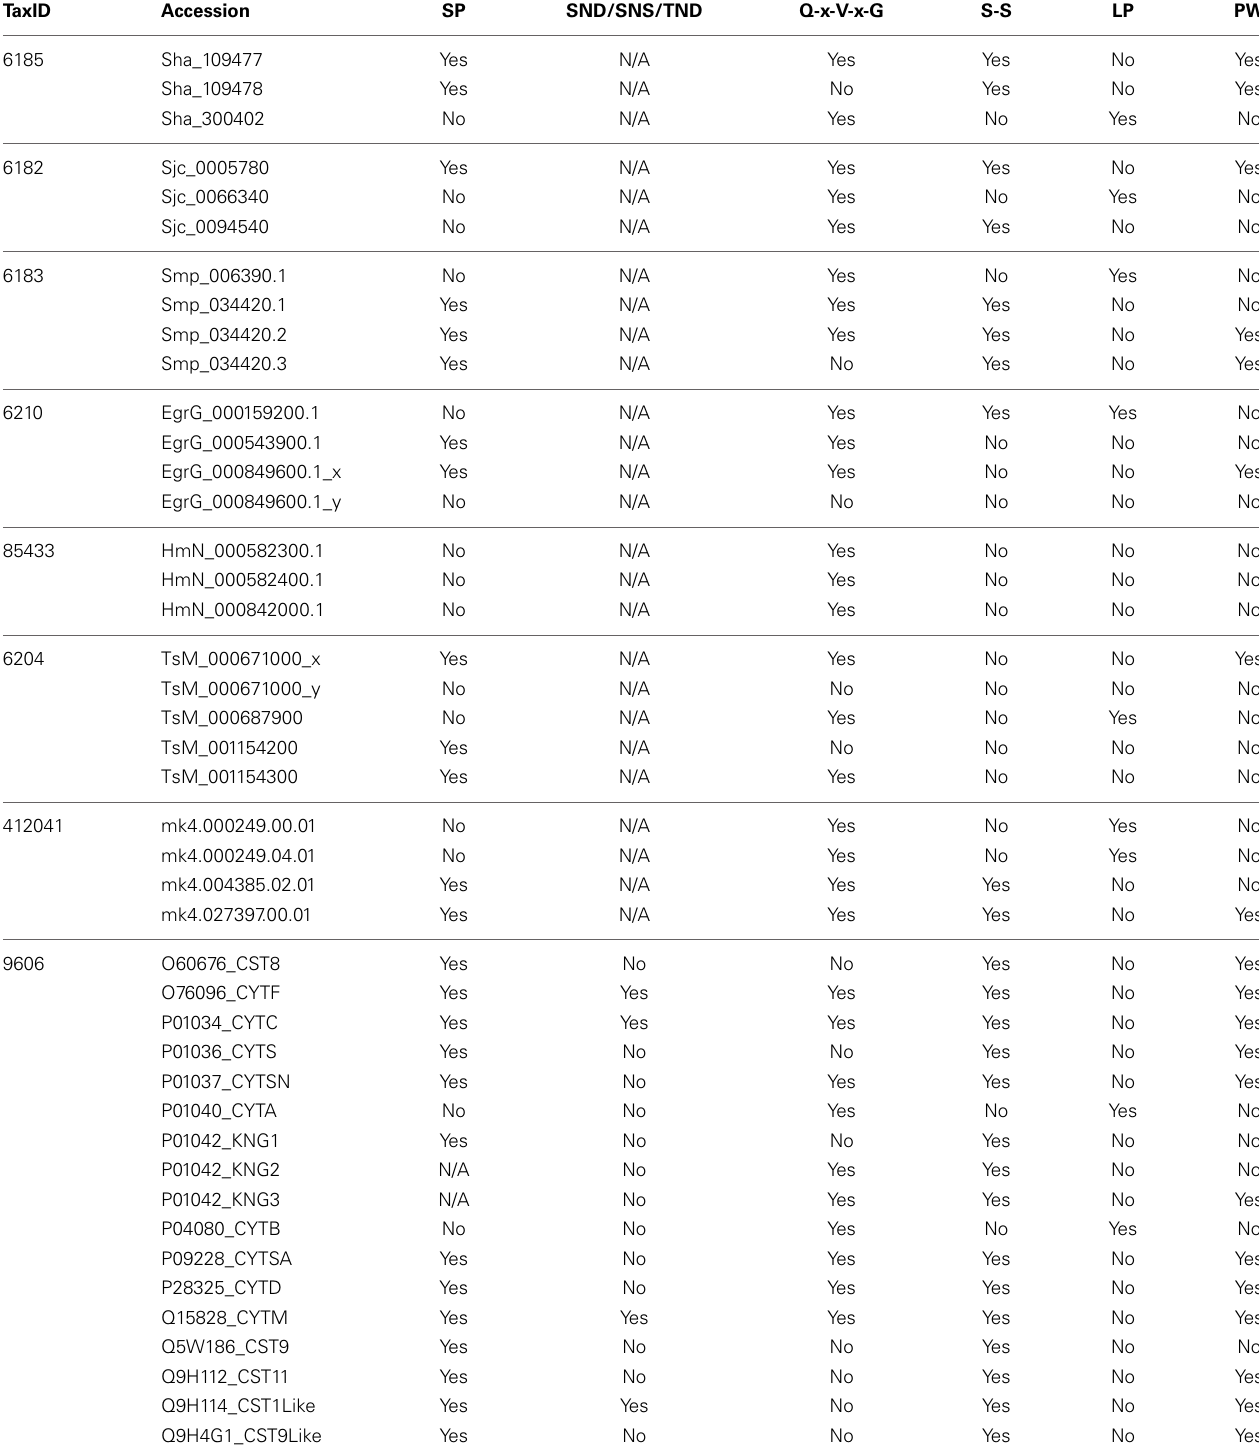
Table 2 | Sequence features of I25 family members in selected